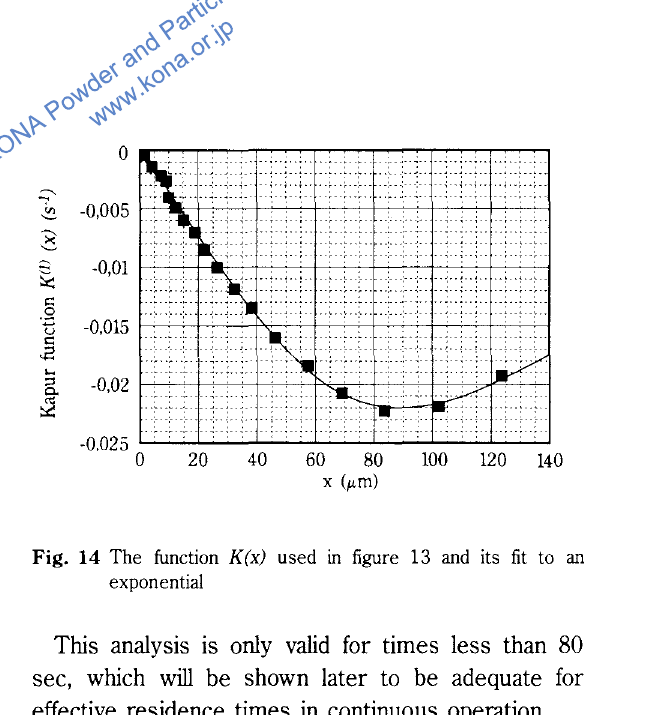
Fig. 16 Flow model for residence time distribution in an air jet mill